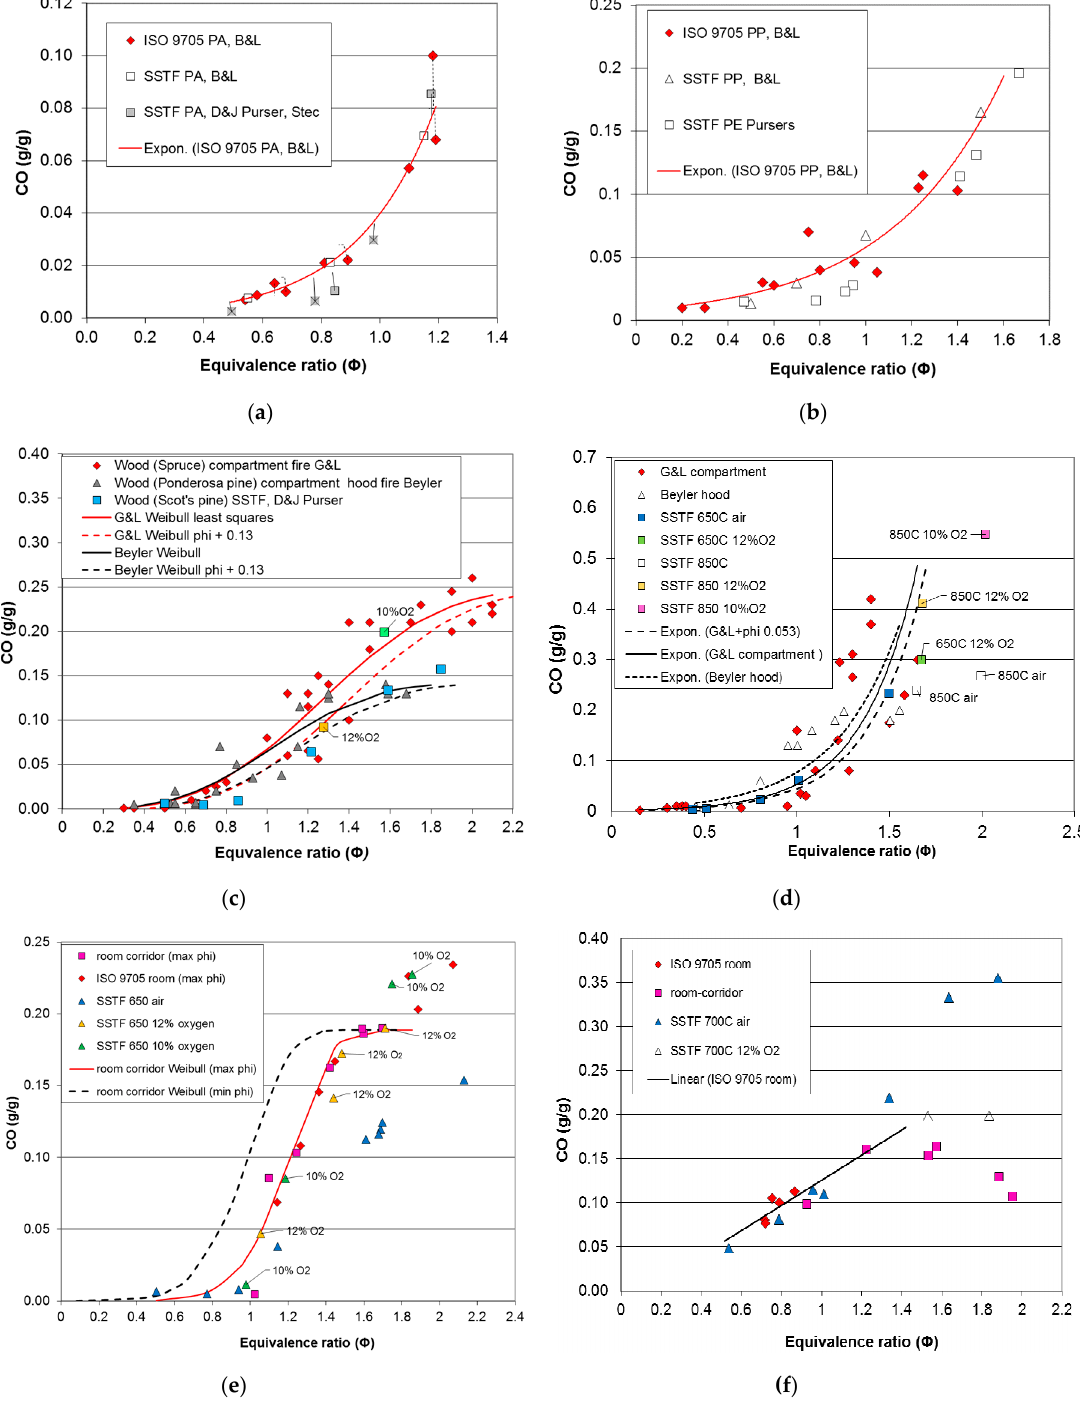
Figure 3. Data points and fitted curves for CO yield (g/g) as a function of equivalence ratio ( Φ ) for six materials measured in compartment fire experiments compared to data points for the same or similar fuels measured in SSTF experiments. ( a ) polyamide 6.6 and 6; ( b ) polypropylene and polyethylene; ( c ) wood; ( d ) polymethylmethacrylate (PMMA); ( e ) medium-density fibreboard (MDF); (f ) polyisocyanurate (PIR). B&L, Blomqvist and Lonnermark; Expon, Exponential.